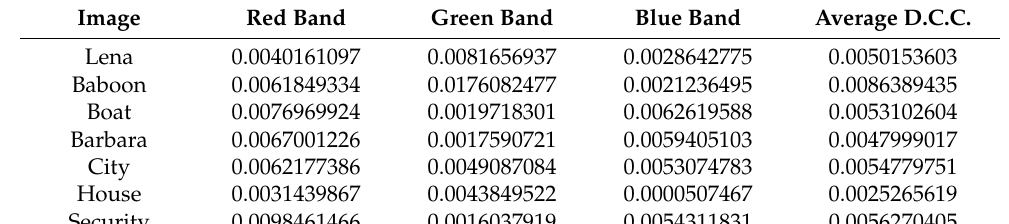
Table 6. Diagonal correlation coefficient results.